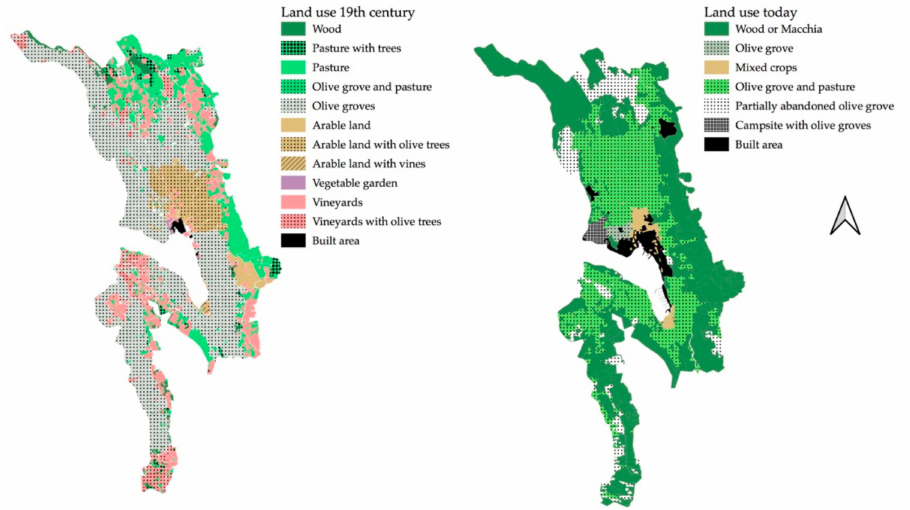
Figure 4. Land use in 1821–1837 and 2016. GIS elaboration based on cartographic analysis of Austrian cadastral maps [53], digital orthophoto imagery from 2016 [40] and ARKOD land registry [54].